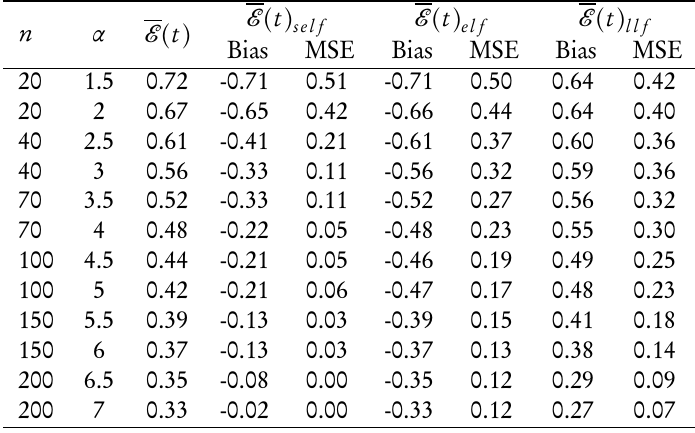
The bias and MSE of Lindley approximation method for Bayes estimators of (cid:69) ( t ) using c = 1 and h = 1